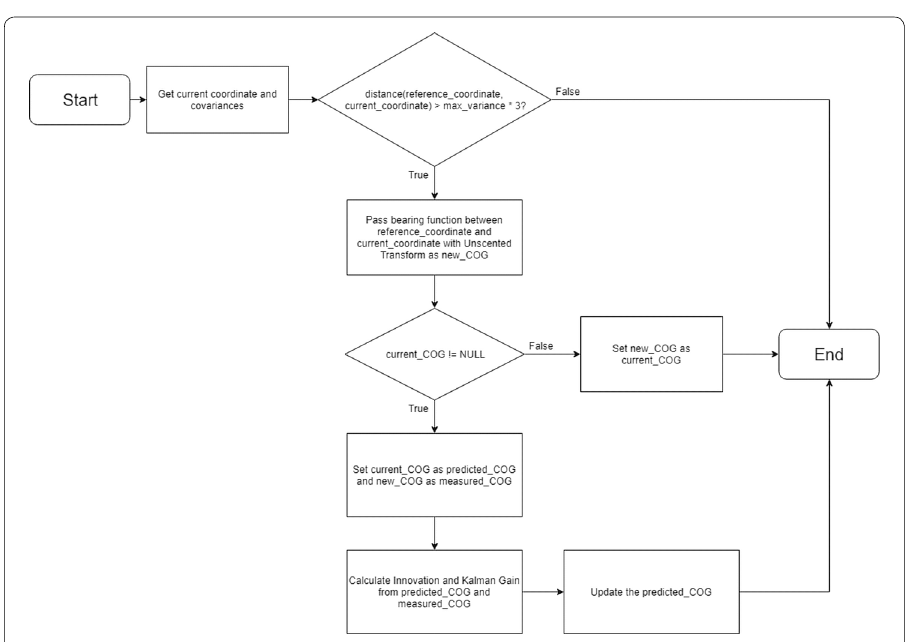
Fig. 8 Course-over-ground calculation